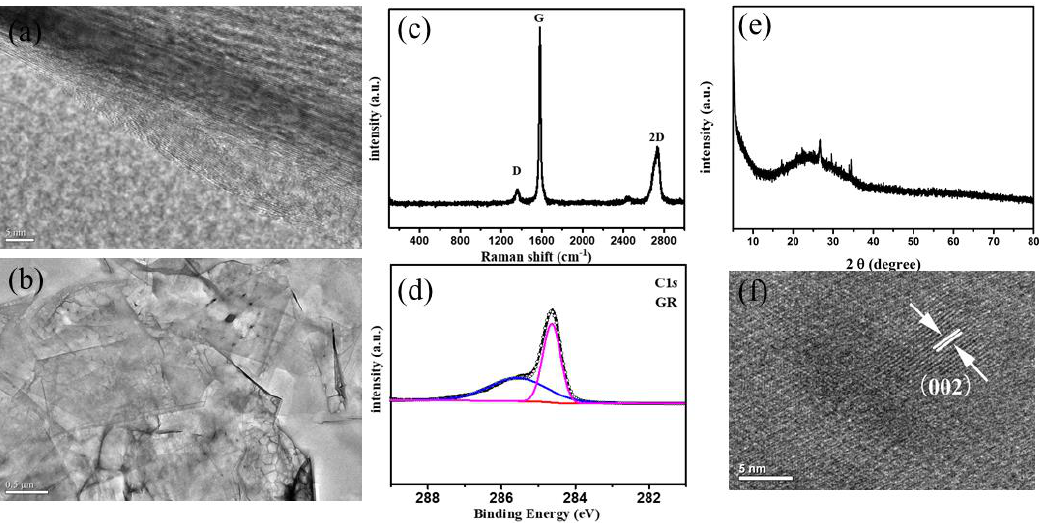
Figure 1. Characterization of the GO ( a ) TEM-5 nm, ( b ) TEM-0.5 μm, ( c ) Raman, ( d ) XPS, ( e ) XRD, ( f ) HR-TEM.